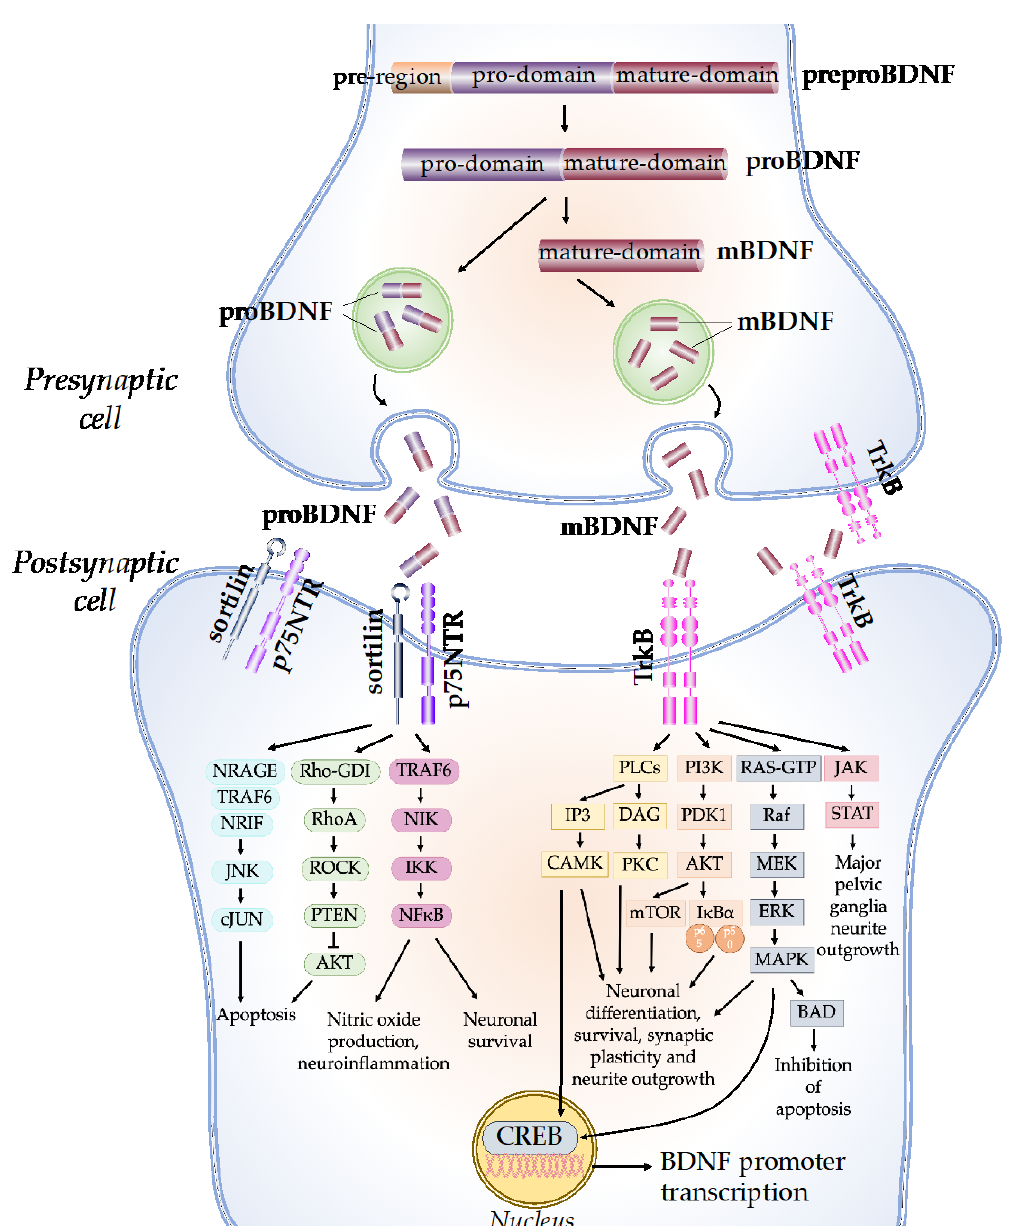
Figure 1. BDNF molecular mechanisms and signaling cascades. The BDNF protein is synthesized as a precursor form, preproBDNF. PreproBDNF is then converted into proBDNF, which consists of a